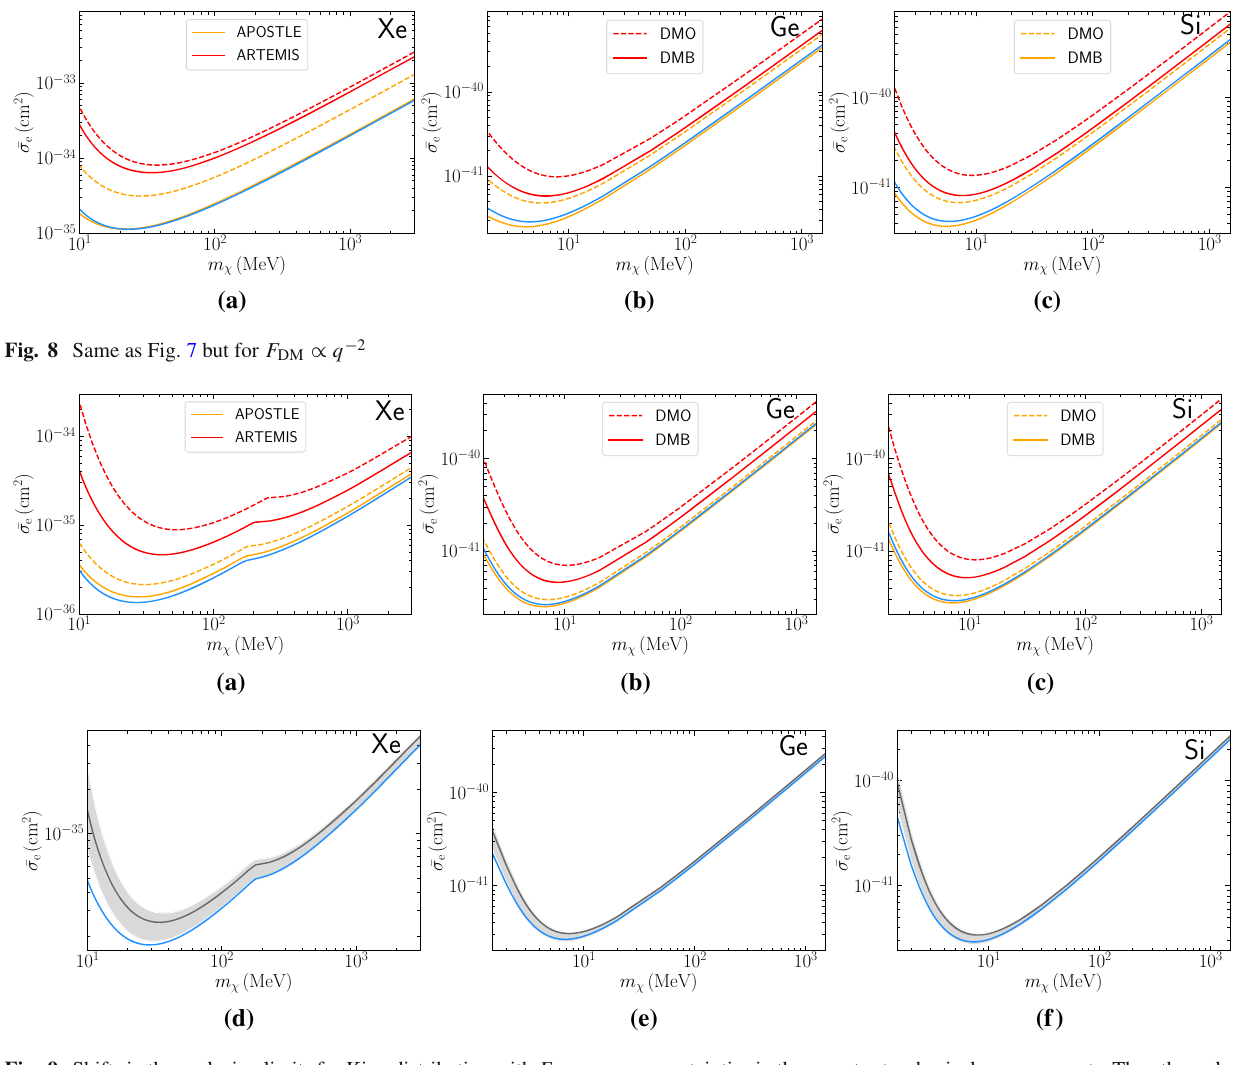
uncertainties in the recent astrophysical measurements. The other rele- vant details are same as of Figs. 1 and